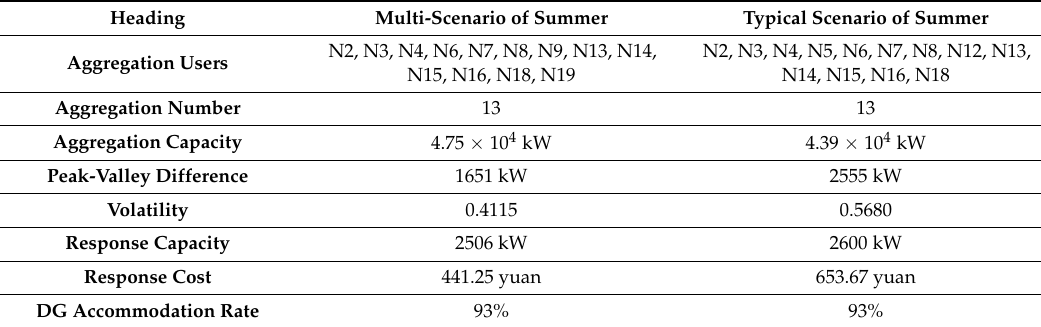
Table 4. The aggregation results of